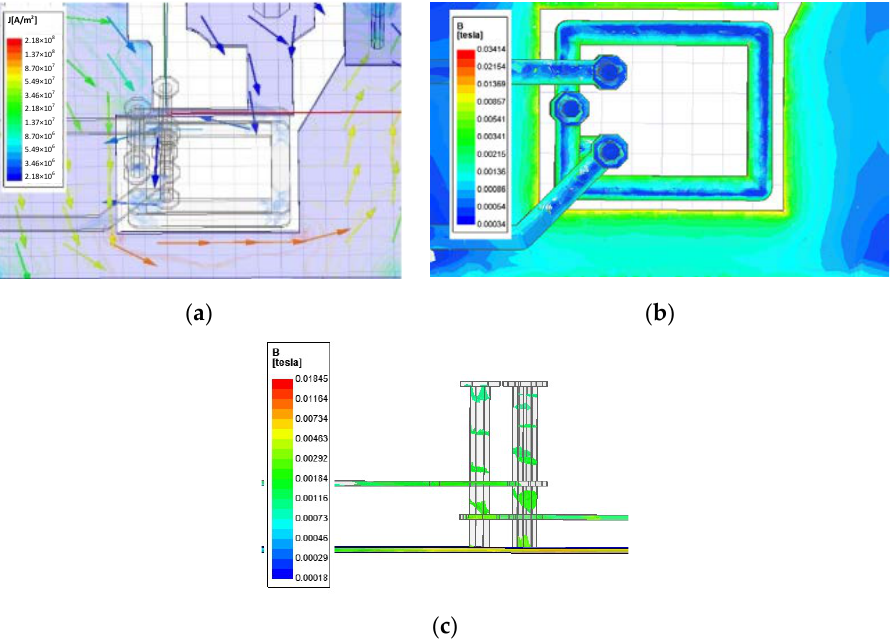
Figure 6. PCB circuit analysis using finite element method: ( a ) current flow of 5 × 10 0 A; ( b ) top view of magnetic flux density; ( c ) side view of magnetic flux density.